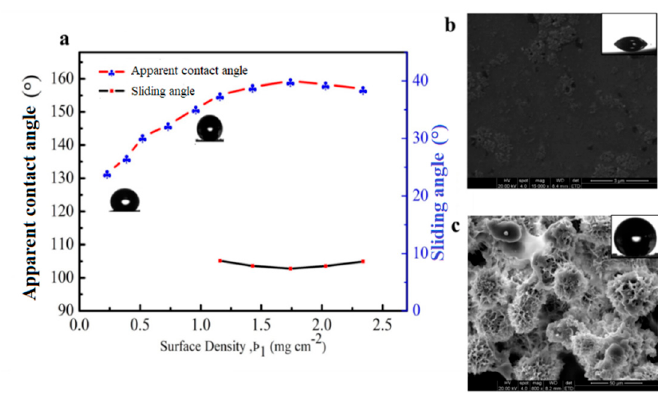
Figure 4. ( a ) The effect of surface density ( ρ ) on apparent contact angle and sliding angle; ( b ) SEM image of pristine glass and ( c ) the coated glass with ρ of 1.74 mg cm − 2 .